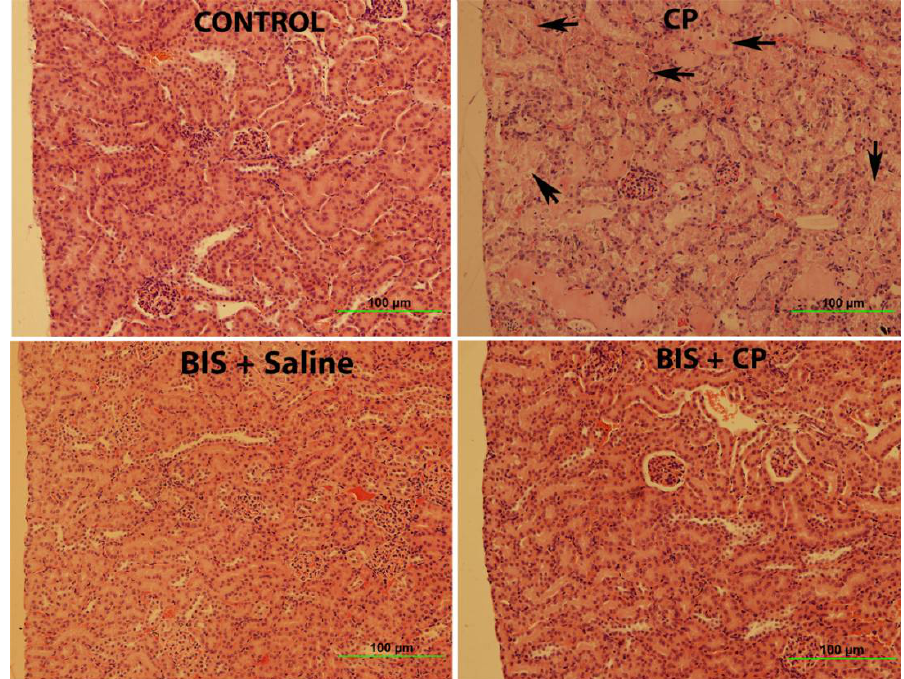
Figure 10. Representative light microscopy sections of renal tissue of mice treated orally with either sunflower oil (control) or bisabolol (BIS, 25 mg/kg) with or without cisplatin (CP, 20 mg/kg) given intraperitoneally (n = 6). The kidney architecture was not affected in the control and BIS-treated groups, with the renal tubules showing a normal appearance and scoring 0. The image in the CP group showed acute tubular necrosis (arrows) was given the score of 3, while the BIS + CP group showed significant improvement in the histological appearance compared to the CP group was scored